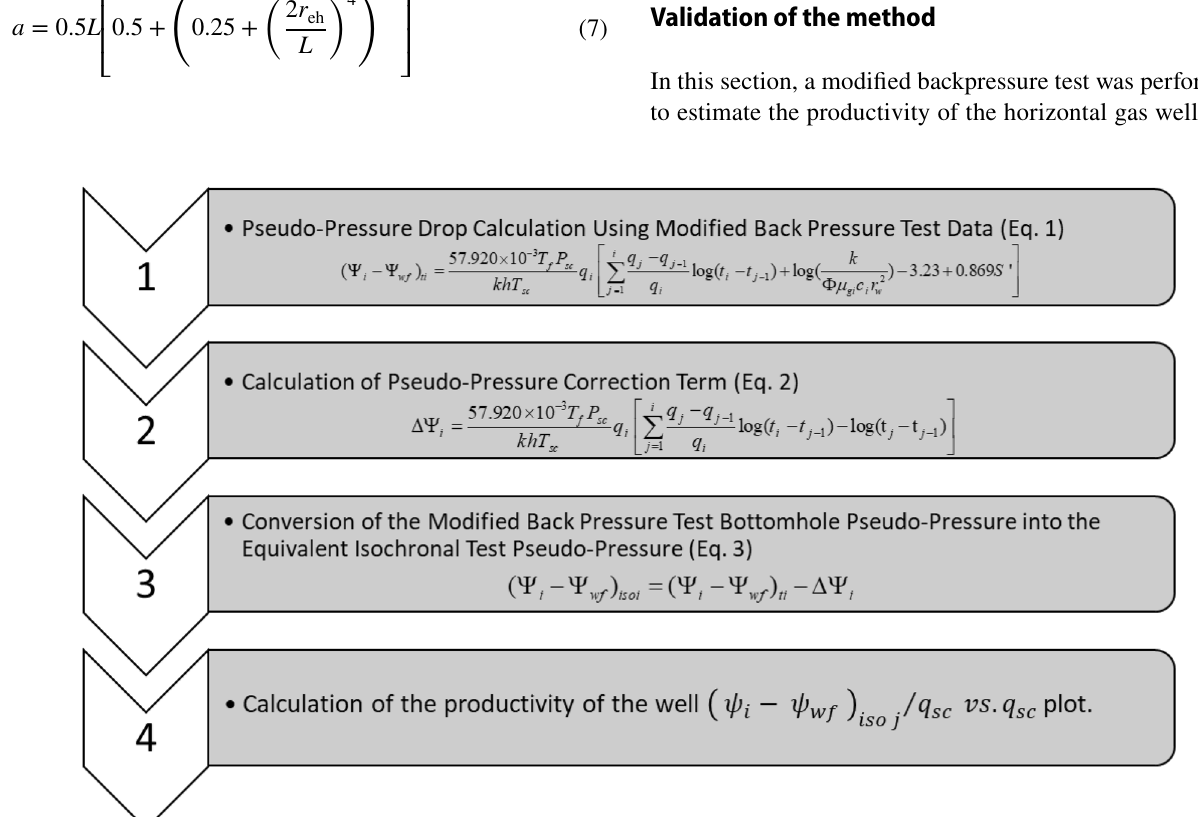
Fig. 2 Schematic view of productivity calculation process for any working system Fig. 3 Schematic description of horizontal well #1 in a synthetic